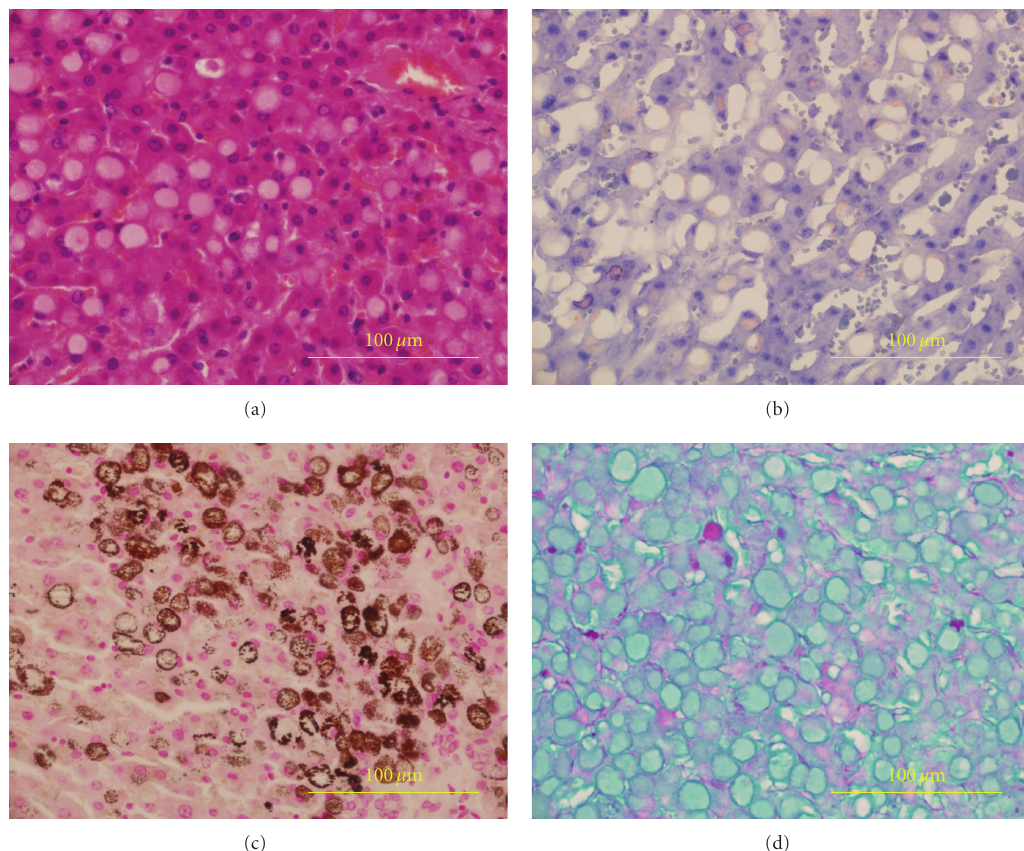
Figure 2: Liver: (a) large intrahepatic cytoplasmic vacuoles filled with pale eosinophilic homogeneous material. Hematoxylin and eosin stain; (b) minimal positive staining for fat in hepatic vacuoles. Oil red O stain; (c) dark brown to black staining indicating calcium (mineral) precipitate in hepatocytes. Von Kossa stain; (d) minimal positive staining for glycogen in hepatic vacuoles. PAS stain.